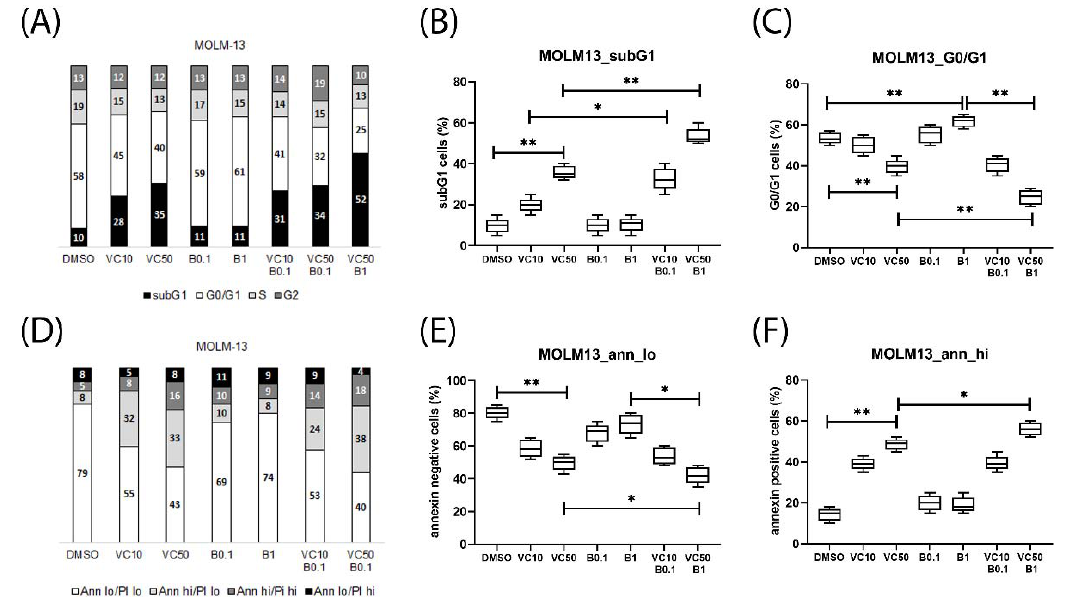
Figure 4. Induction of apoptosis, cell cycle arrest and cell death in MOLM_13 cells treated with venetoclax and bimiralisib. Cytometric analysis of MOLM ‐ 13 cells treated for 20 h with 10 nM or 50 nM venetoclax (VC) and 0.1 μ M or 1 μ M bimiralisib alone or in combination. Depending on DAPI staining intensity cells were classified as subG1, G0/G1, S phase, or G2 phase ( A ). Treatment ‐ induced cell death (subG1 fraction) ( B ), and G1 cell cycle arrest ( C ). Depending on Annexin V and PI staining intensity, cells were classified as vital (Ann lo, PI lo), early apoptotic (Ann hi, PI lo), late apoptotic (Ann hi, PI hi) or necrotic (Ann lo, PI hi) ( D ). Treatment ‐ induced loss of vital cells ( E ) and amount of apoptotic cells ( F ) were significanty enhanced in the combination treatment. Significance of differences in median values was calculated by the Mann–Whitney test. Significance denoted for p < 0.05 (*); p < 0.005 (**); no significance denoted for p > 0.05. 2.5. Venetoclax Combination Treatments with Differential Efficacy in Subsets of AML Patients After initial studies in AML cell lines, the treatment combinations of venetoclax with A1331825, S63845, bimiralisib, trametinib, C ‐ 188 ‐ 9, or PTC596 were applied to patient ‐ de ‐ rived mononuclear cells isolated from peripheral blood (PBMC) or bone marrow (BMMC) (Table 4). A total of 26 AML, one CML, two NHL, as well as PBMCs of four healthy donors (HD) were subjected to single compound and combination treatments. The tested combi ‐ nation treatments induced minor reduction of cell viabilities in mononuclear cells isolated from healthy donors, and substantial reduction of cell viability in 50–70% of AML samples treated with venetoclax monotherapy (Figure 5A) or in combination with A1331825, S63845 or bimiralisib (Figure 5B–D). Venetoclax in combination with trametinib, C ‐ 188 ‐ 9 or PTC ‐ 596 was less effective with substantial reduction of cell viability in 20–40% of AML